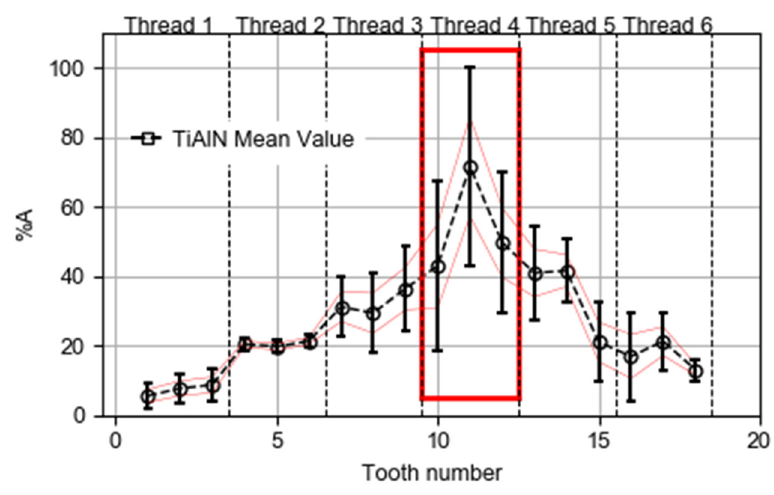
Figure 17. Evolution of mean %A on the teeth of TiAlN coated taps.